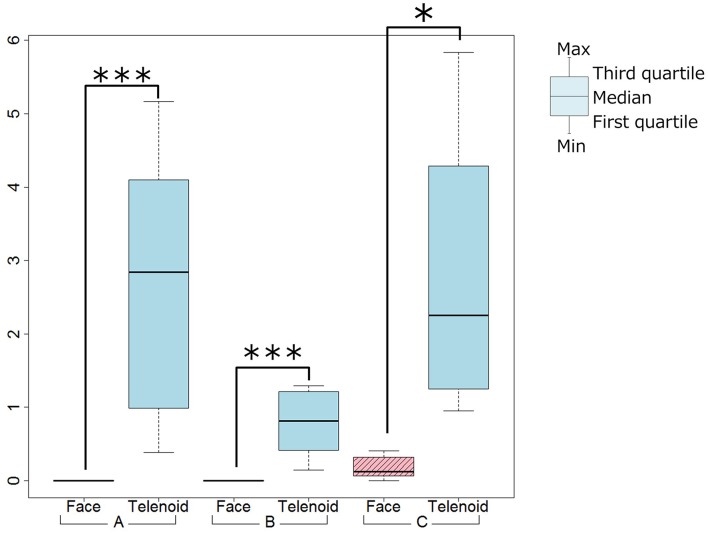
Physical contact tendency (*p < 0.1, **p < 0.05, ***p < 0.01).